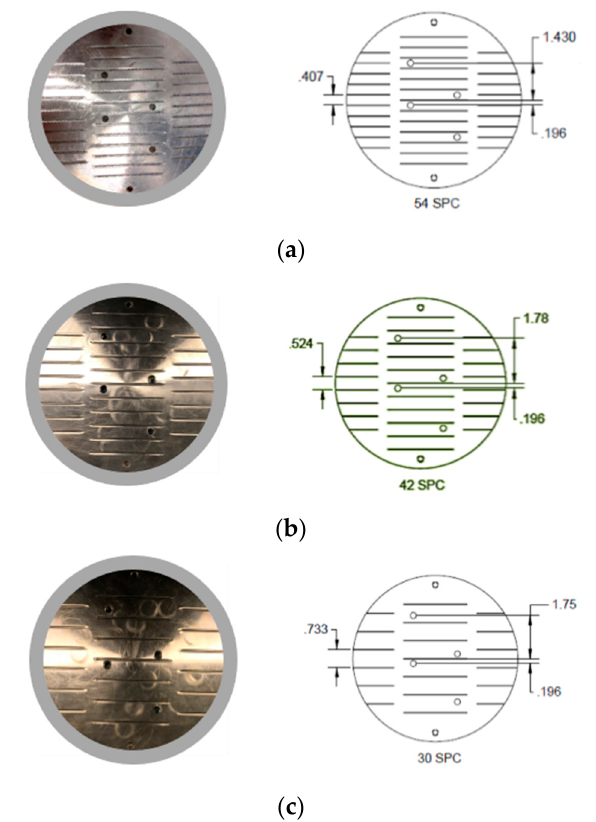
Figure 7. Image and dimensions of multi-slotted coupons: ( a ) 0.014 ′′ –0.022 ′′ SPC: 54, ( b ) 0.018 ′′ –0.026 ′′ SPC: 42, ( c ) 0.026 ′′ –0.034 ′′ SPC: 30.